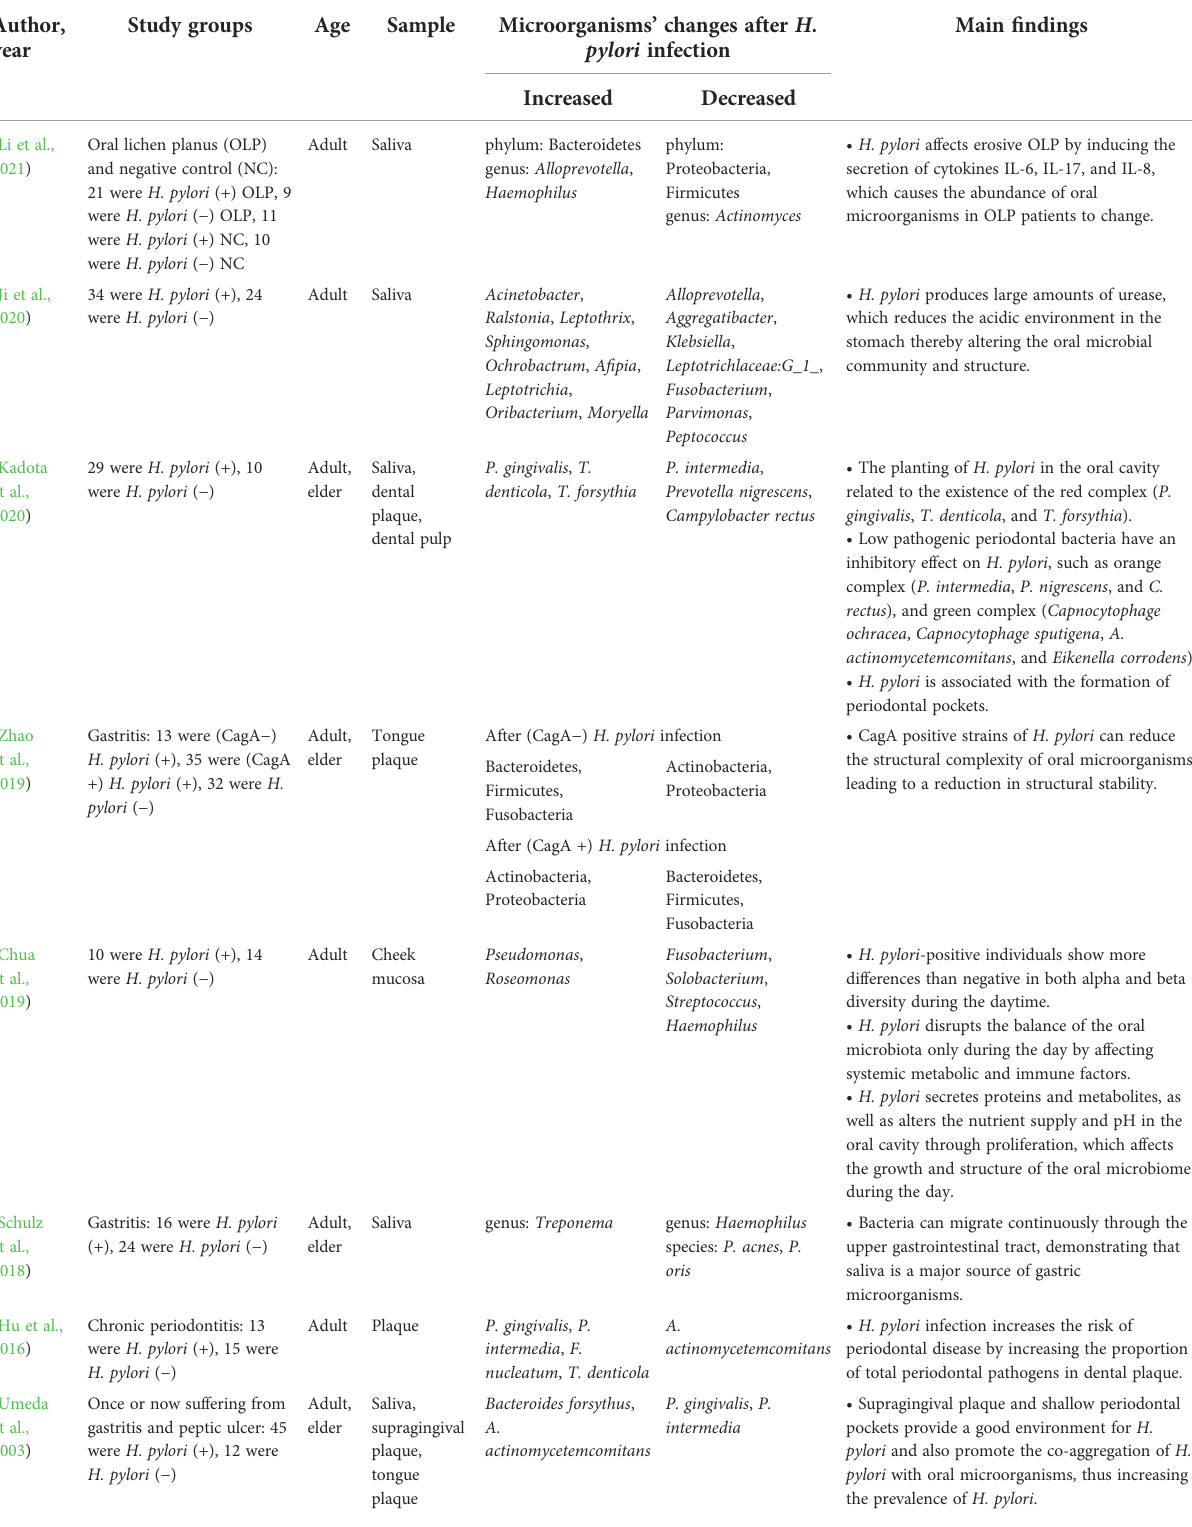
TABLE 1 Studies assessing the in fl uence of Helicobacter pylori (H. pylori ) infection on oral